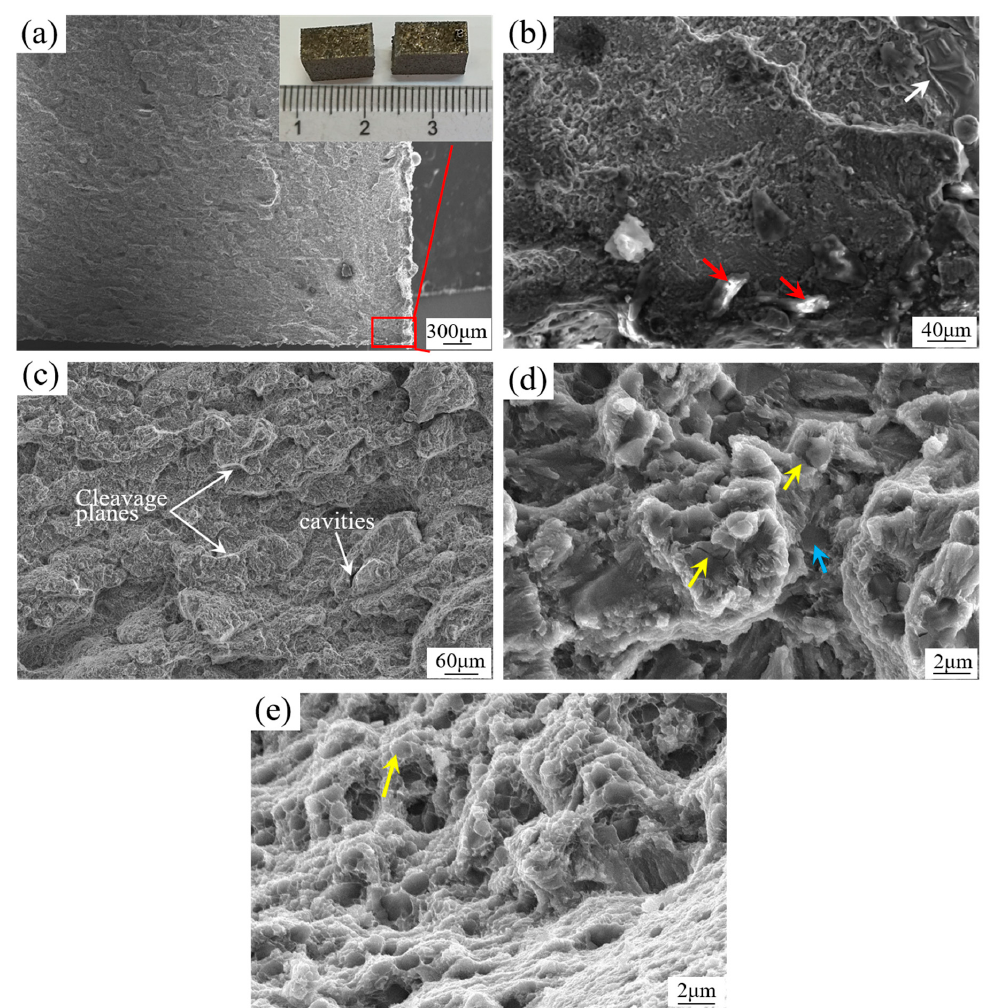
Figure 10. Bending fraction morphologies of the as-built Al-Si alloys. ( a ) Overall view of the fracture sample and its crack initiation region (marked by red frame) is magnified in picture ( b ), with inclusions and notch defects pointed out by red and white arrows, respectively. ( c ) Partially magnified image of the fracture surface. Two different fracture morphologies are illustrated at higher magnifications in the picture ( d , e ), with fractured and debonding Si particles marked by yellow and blue arrows, respectively.